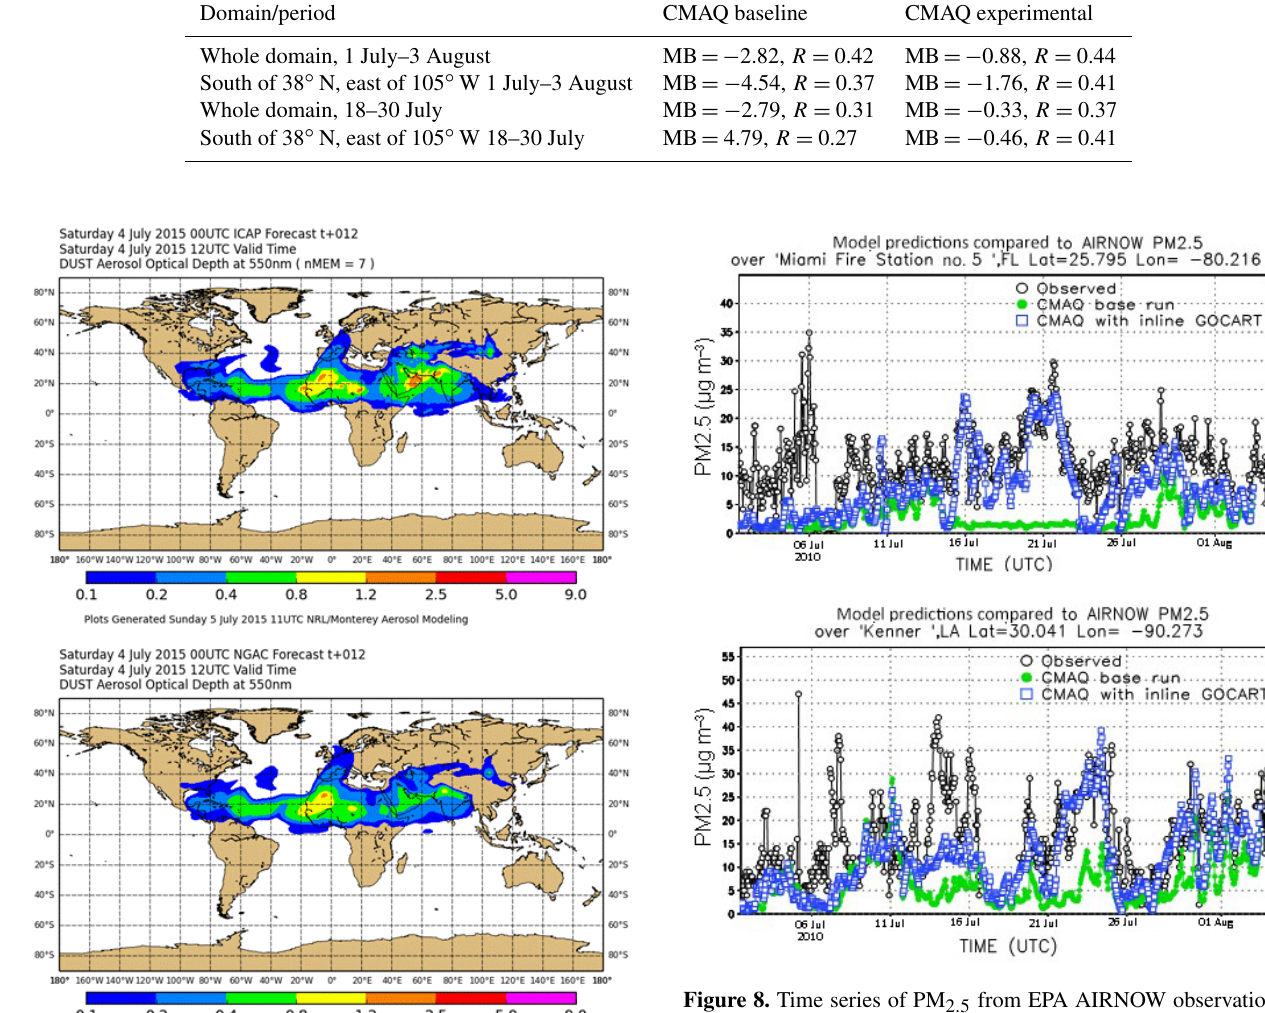
Figure 8. Time series of PM 2 . 5 from EPA AIRNOW observations (black dot), CMAQ baseline run using static LBCs (green dot), and CMAQ experimental run using NGAC LBCs (blue square) at Mi- ami, FL (top panel) and Kenner, LA (bottom